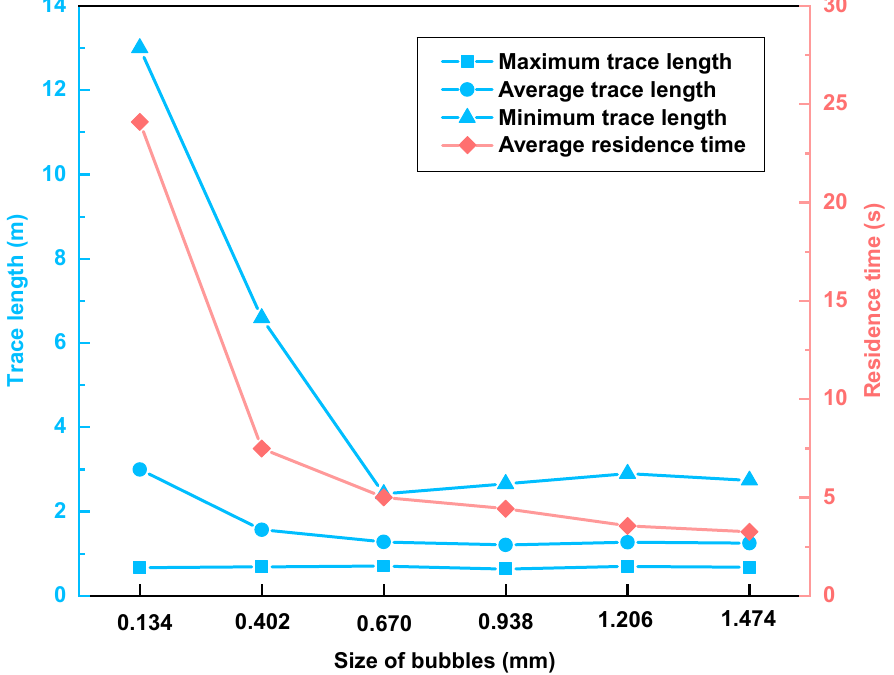
Figure 13. Statistics results of motion trace and residence time for bubbles at different sizes.